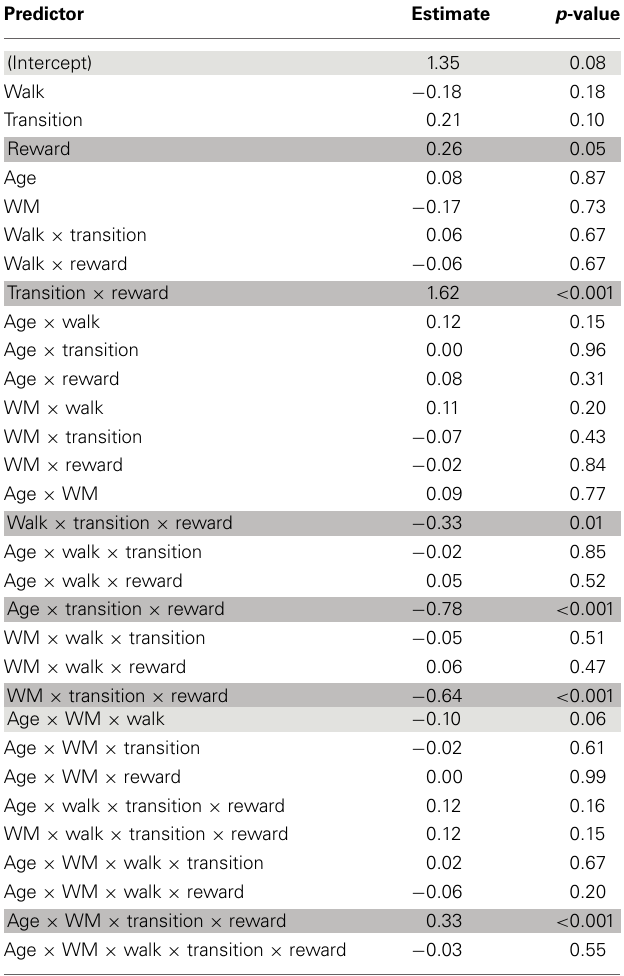
Table 3 | Results of the logistic regression analysis with the between subjects factors Age group and Working memory capacity and the within subjects factors Probability range condition (walk), transition type and reward.